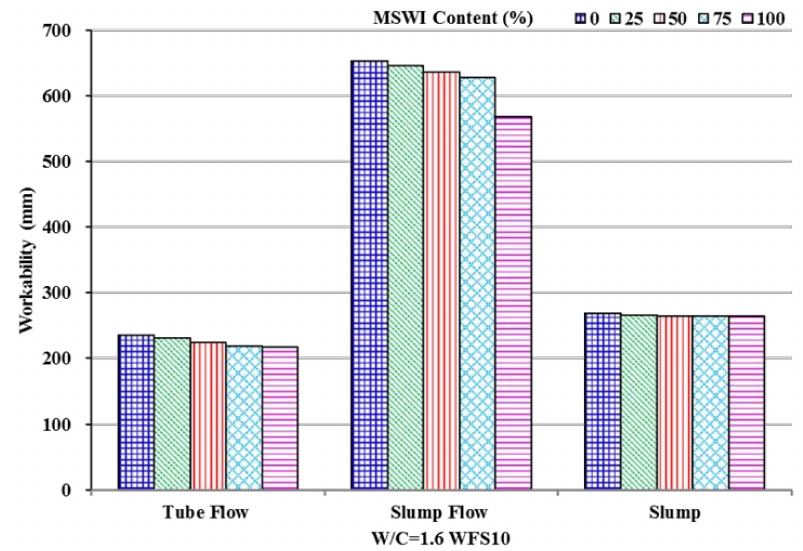
Figure 2. Effect of MSWI content on